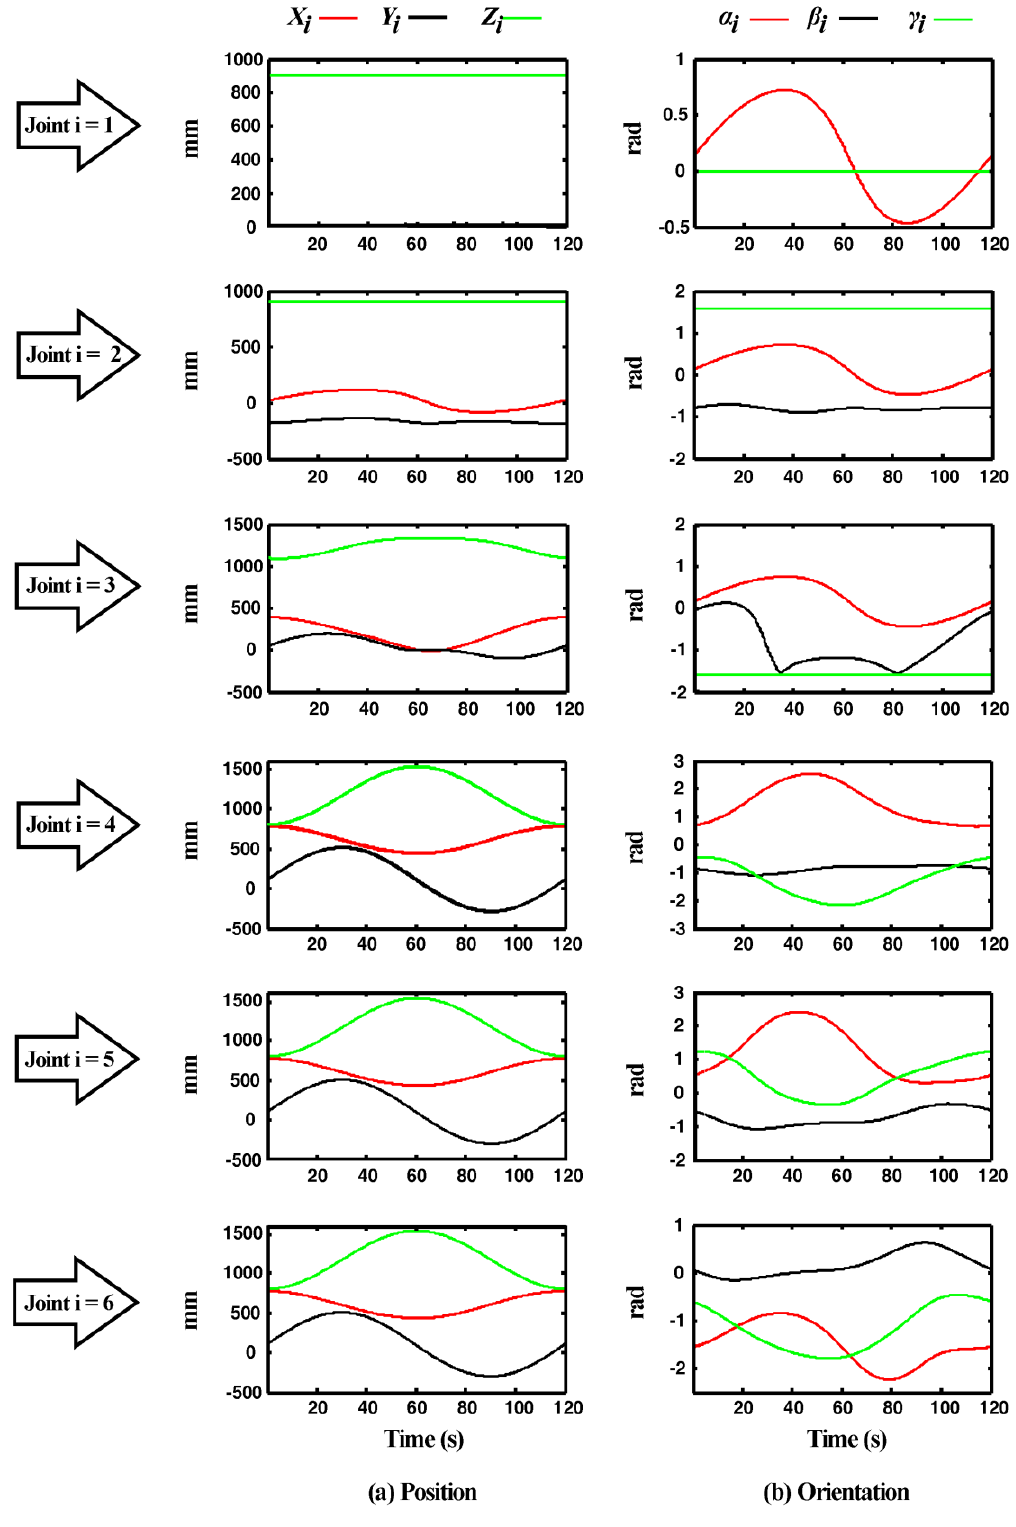
Figure 12. Each-joint forward kinematics (a) position, (b)